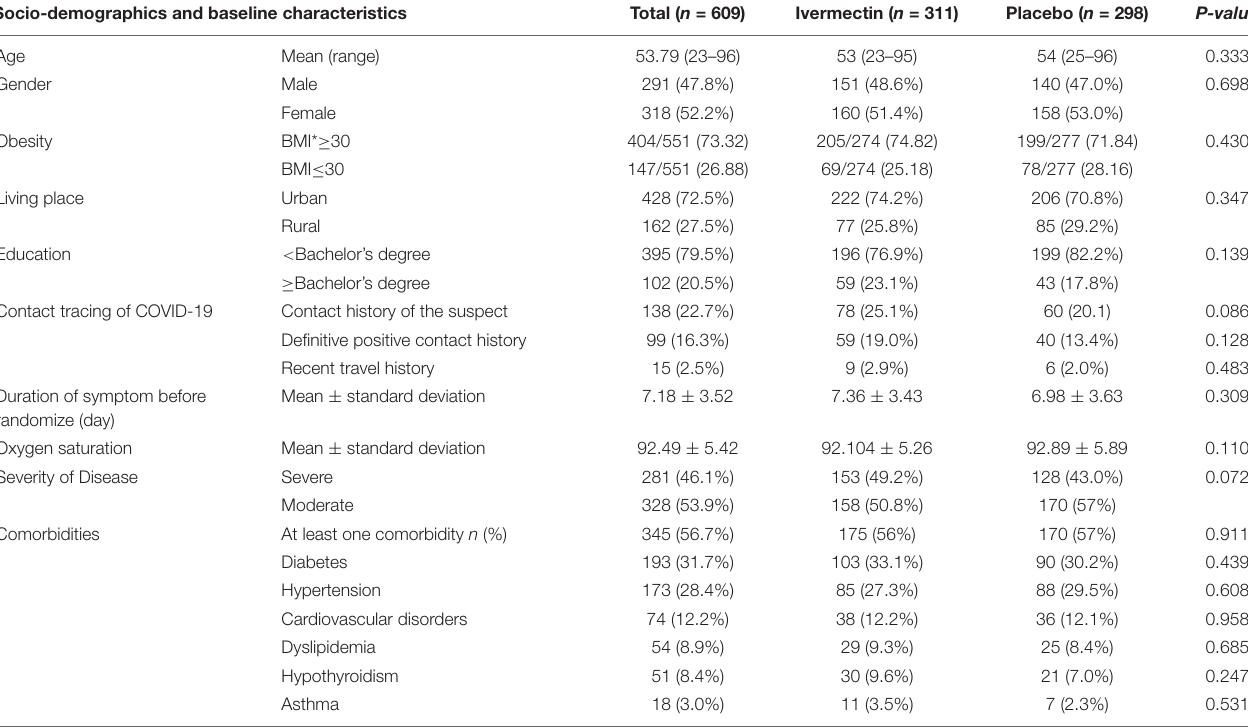
TABLE 1 | The socio-demographics and baseline characteristics of inpatients.